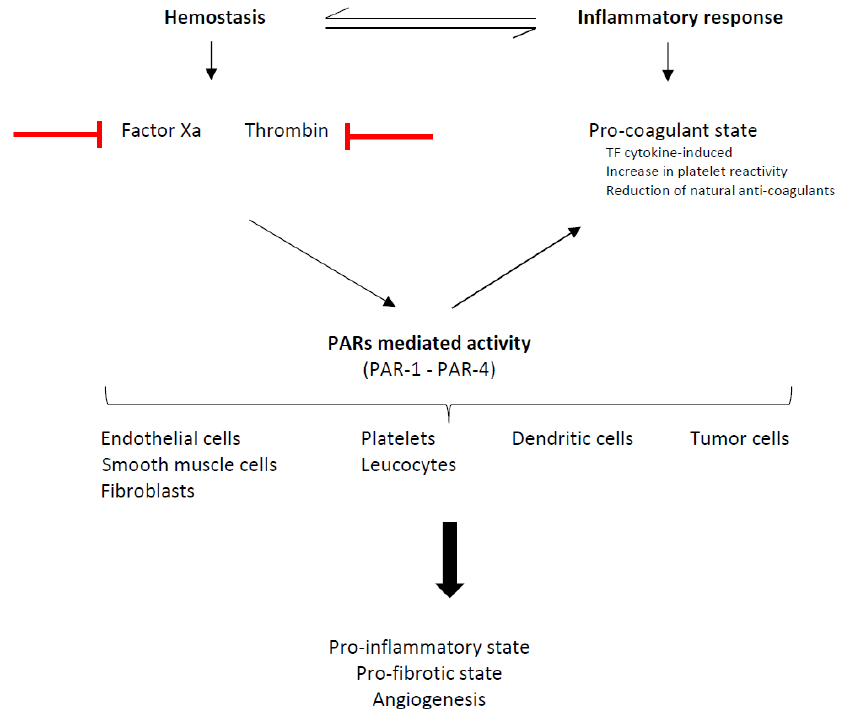
Figure 1. Schematic representation of the interaction between hemostasis and inflammation promoting tumor progression. PARs (protease-activated receptors) are expressed on several cells. Thrombin activates PAR-1, PAR-3 and PAR-4. Factor Xa, alone or bound to the tissue factor (TF)–activated factor VII (VIIa) complex, activates PAR-1 and PAR-2. In red: inhibition of either thrombin or factor Xa could potentially inhibit cancer